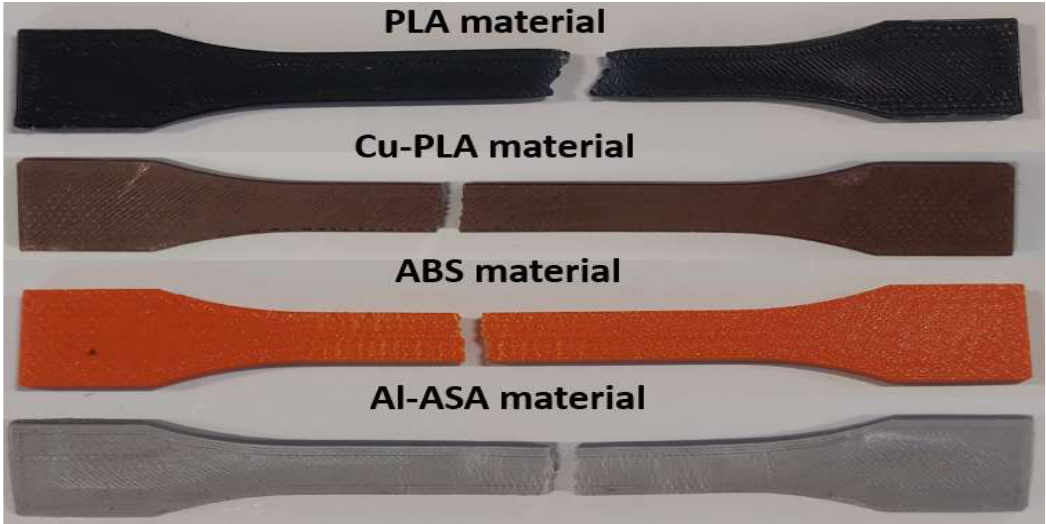
Figure 11. Fractured samples from the four materials.